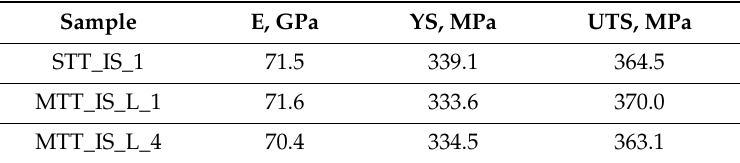
Table A2. Tensile test results for IS